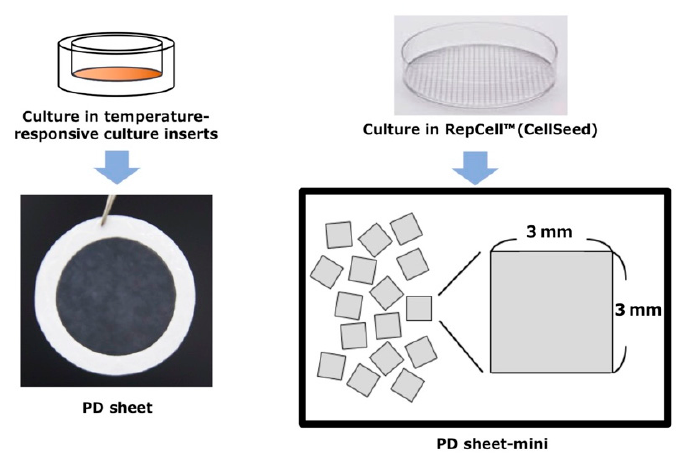
Figure 1. Fabrication of polydactyly-derived chondrocyte (PD) sheets and mini PD sheets. PD sheets and mini PD sheets were fabricated in temperature-responsive culture inserts called Up- Cell® (cid:0) and temperature-responsive culture dishes called RepCell™ (CellSeed Inc.), respectively. RepCell™ is a unique culture dish with grid walls etched onto the culture surface creating 3 mm × 3 mm grids.